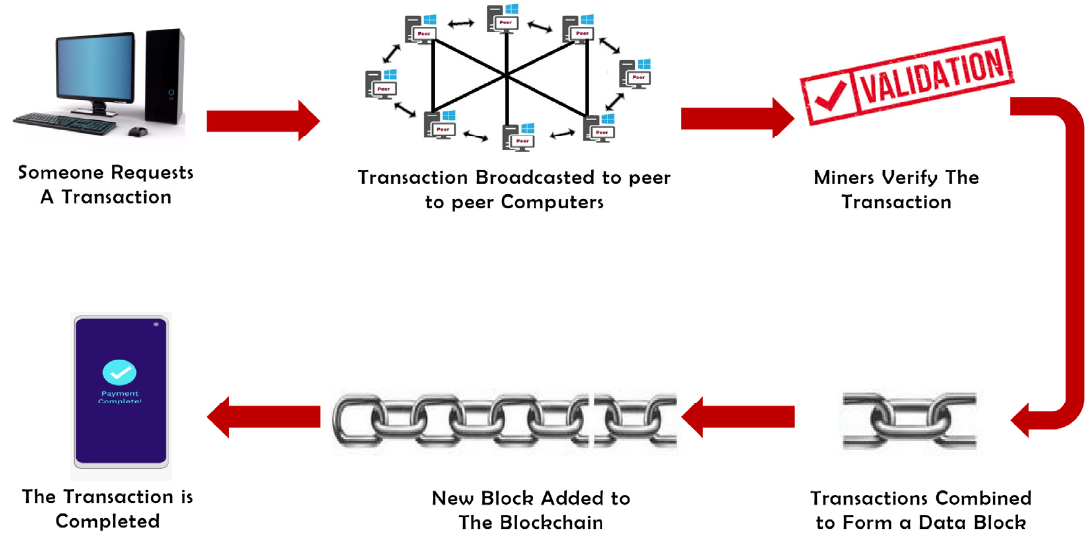
Figure 5. Architecture of machine learning-based Bitcoin Transaction Predictive Model.